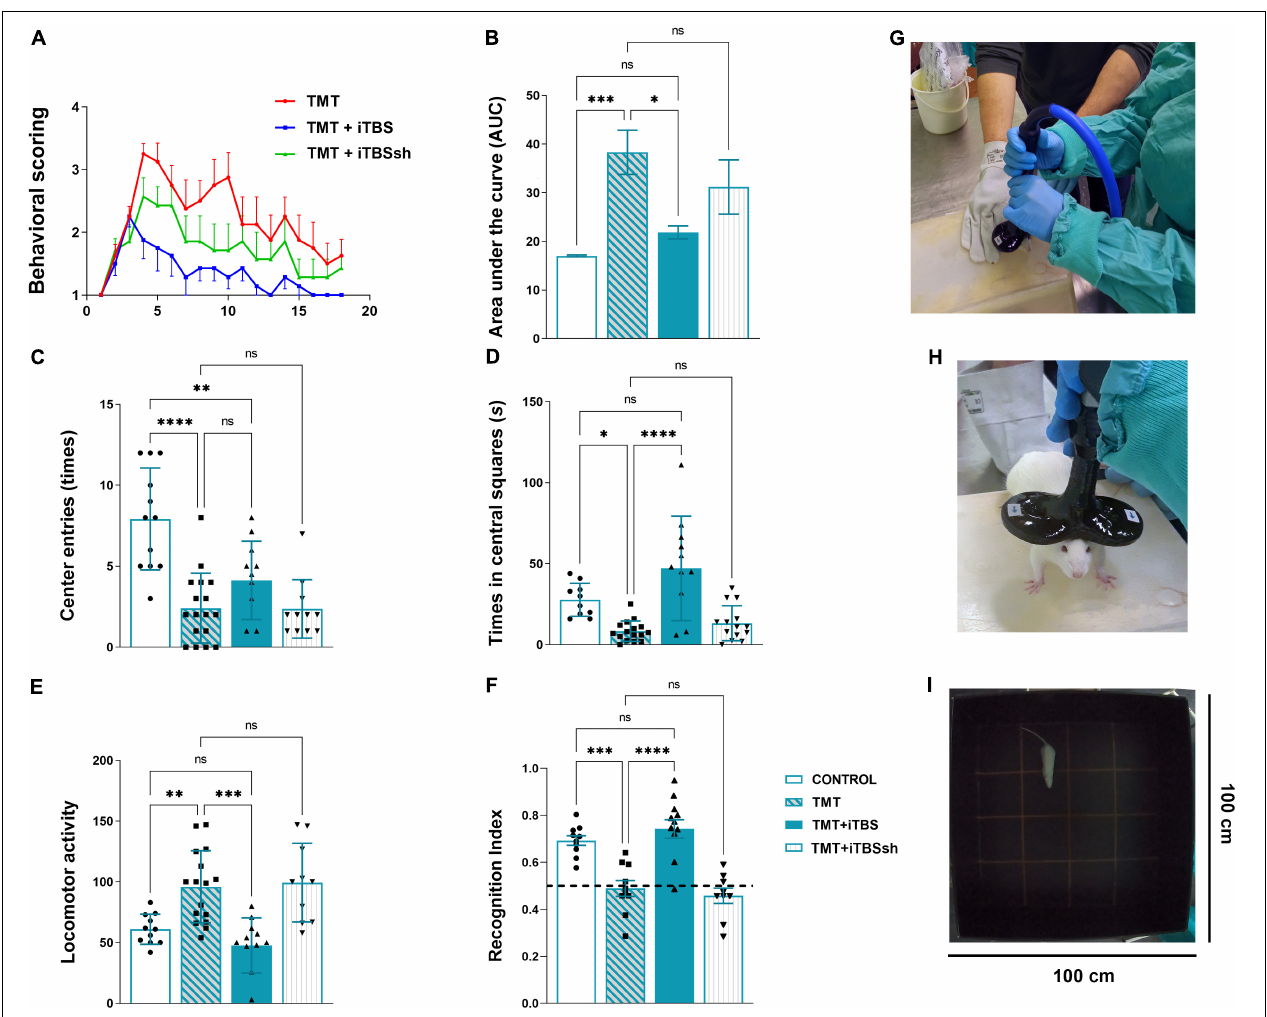
FIGURE 2 | Effect of iTBS treatment on behavior of TMT rats. (A) Graphic and (B) quantitative analysis of behavioral animal scoring. Bars represent the mean AUC ± SD. (C,D) Anxiety-like behavior and (E) motor activity, assessed in the open-field test. Bars represent (C) a mean number of entries, (D) a mean duration spent in central squares (s), and (E) a mean total movements, ± SD. (F) Recognition index determined by the novel object recognition test. Bars represent mean recognition index ± SD. Interrupted line represents 50% of recognition index, where animals showed no discrimination between novel and familiar object. Results